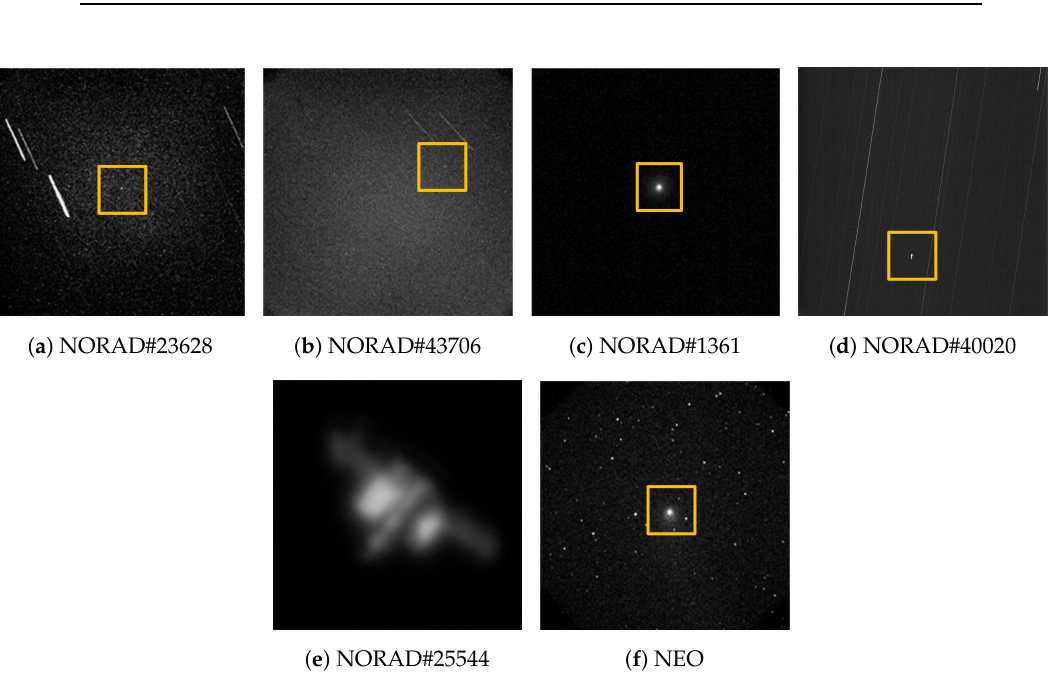
Figure 2. Tracking datasets of space targets with known orbital parameters labeled by ( a , b ) are Geostationary and Medium Earth orbit objects respectively. ( c , d ) are Low Earth orbit object. Lastly, ( e ) is the Near-Earth Object (NEO): Africano. Orange rectangles: Observations with Regions of Interest (ROIs) around space targets. Observation date: July–September